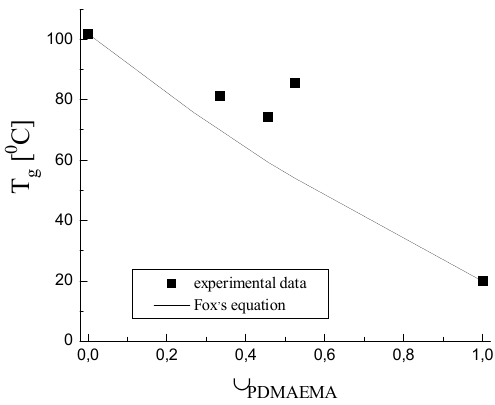
Figure 6. Relationship between the experimentally determined by DSC T g of PDMAEMA/PAAm IPNs and their composition, ϕ PDMAEMA (the black line is drawn following the Fox equation, Equation (S5) in Supplementary Information).